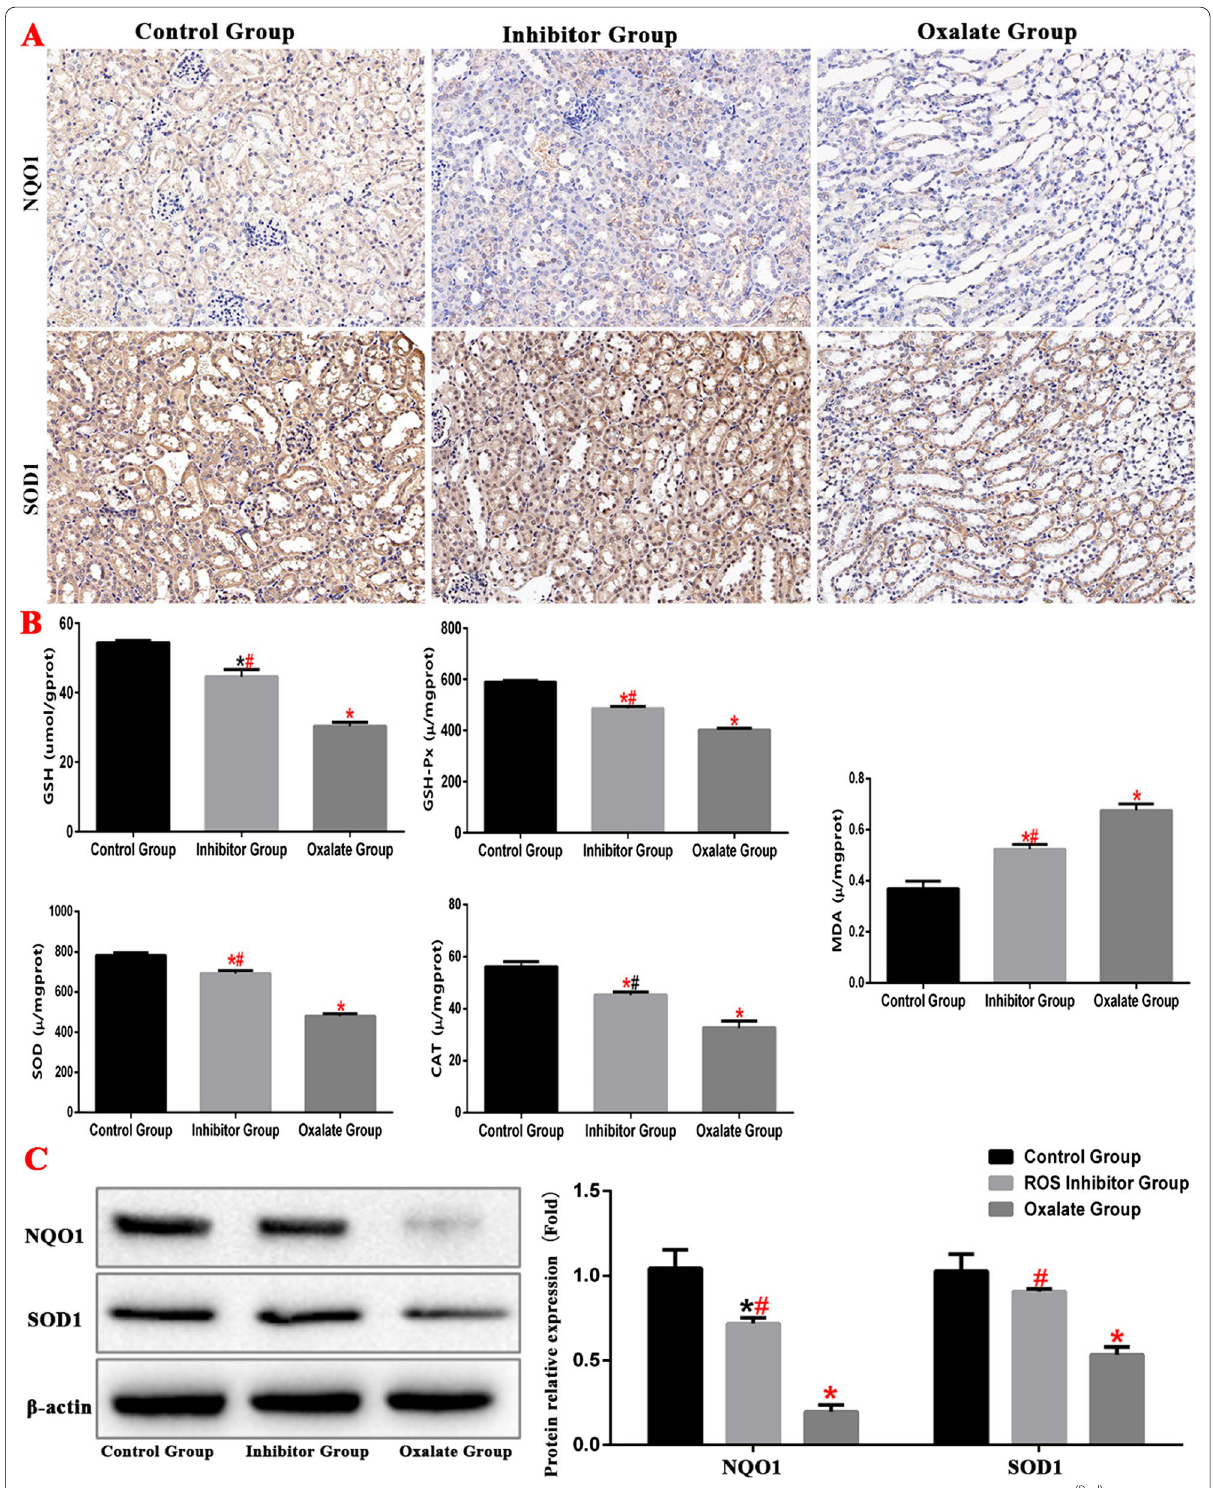
Fig. 9 ERS and ROS protein expression level in kidney tissue of mice in each group. (*compared with normal control group, P < 0.05.* (Red) Compared with control group, P < 0.01. # Compared with oxalate group, P < 0.05. #(Red) Compared with oxalate group, P <